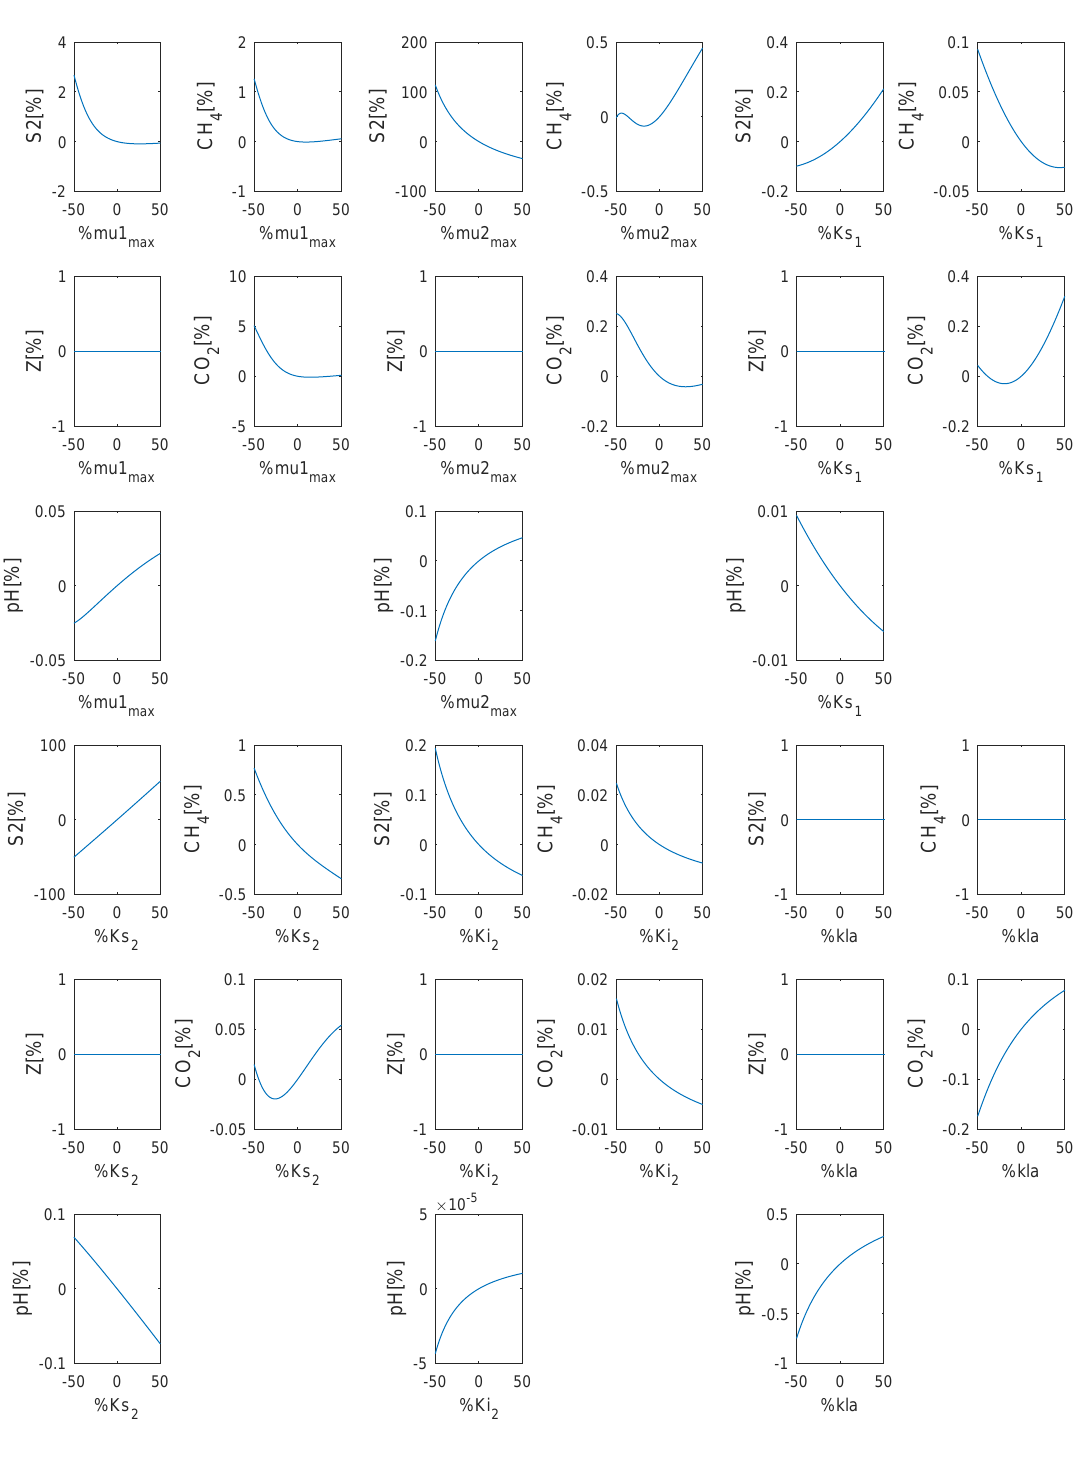
Figure 7: The sensitivity for the kinetic and k La model